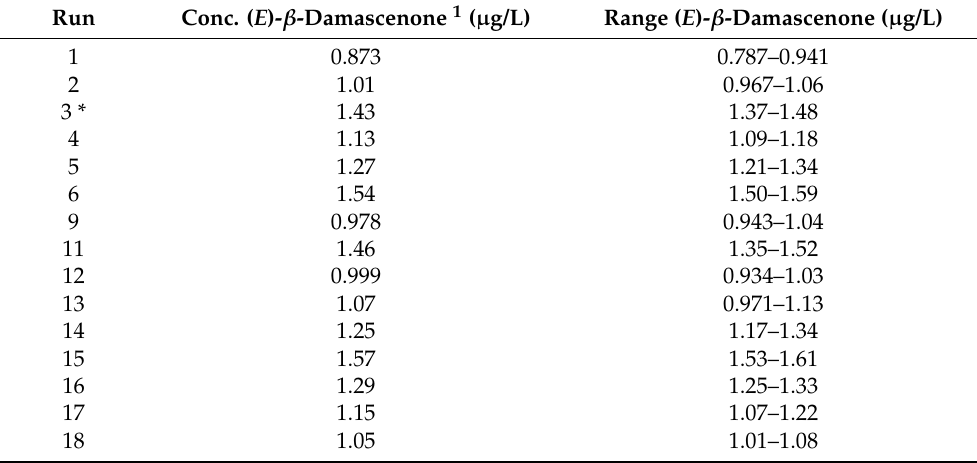
Table 6. Concentrations of ( E )- β -damascenone ( µ g/L) in the beer samples fermented according to response surface methodology (RSM)